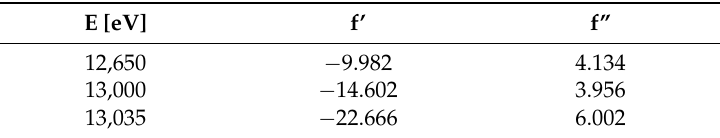
Table 2. The anomalous dispersion corrections of Pb at the three energies of the ASAXS experiment based on the calculations of Cromer and Liberman